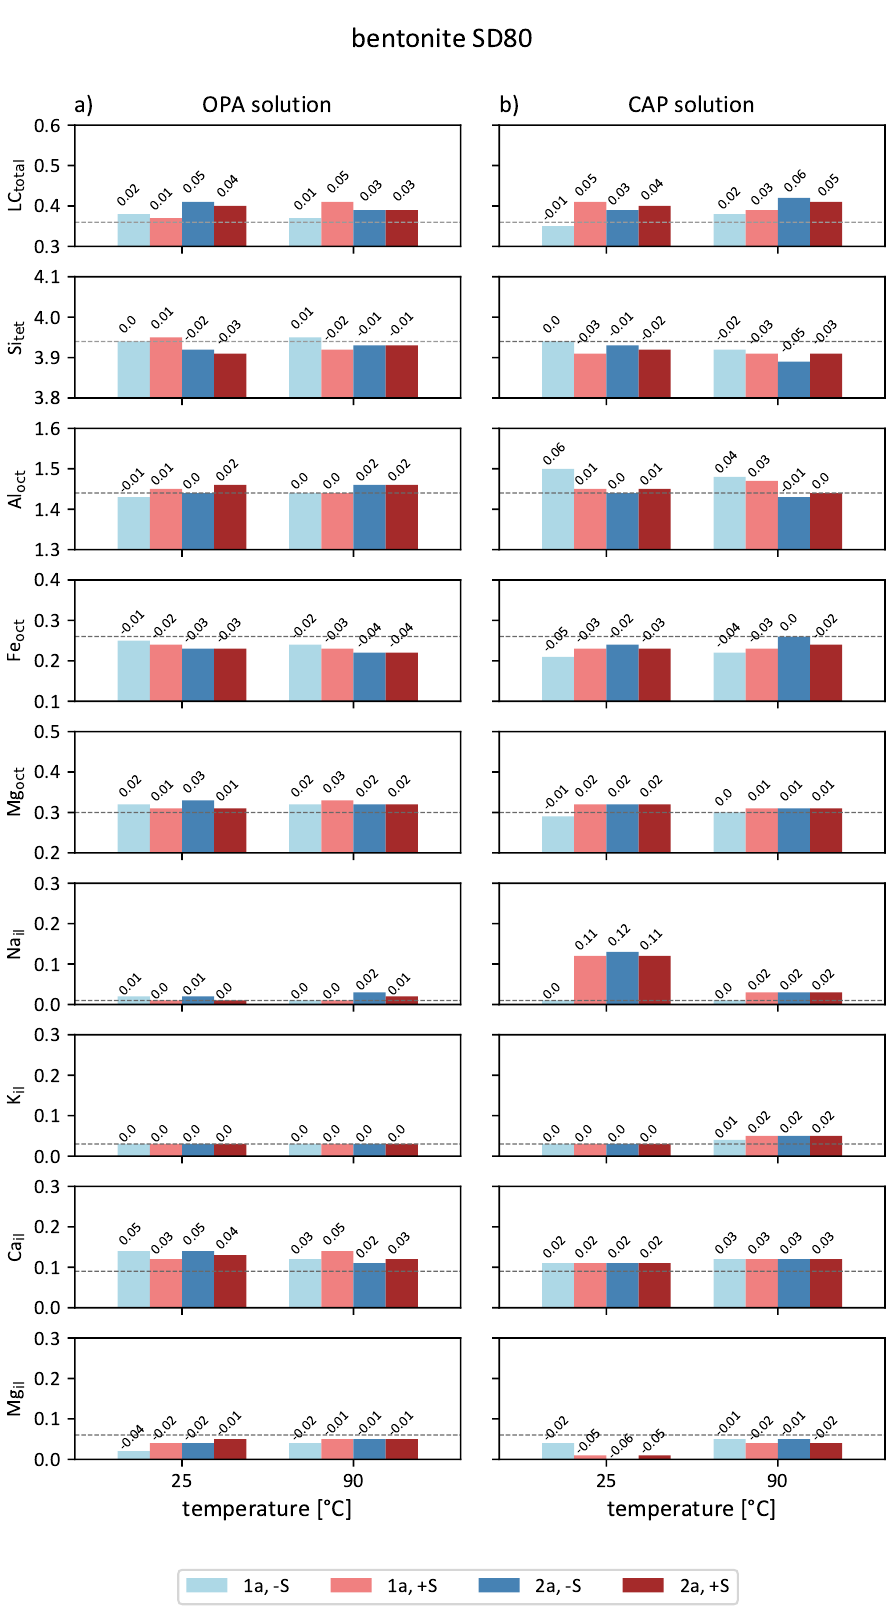
Figure 7. Layer charge and cation distribution of SD80 batch experiments with ( a ) OPA solution and with ( b ) CAP solution; tet: tetrahedral sheet, oct: octahedral sheet, il: interlayer. Values above the bars are displaying the rounded deviation (in e · phuc − 1 ) from the initial sample (dotted